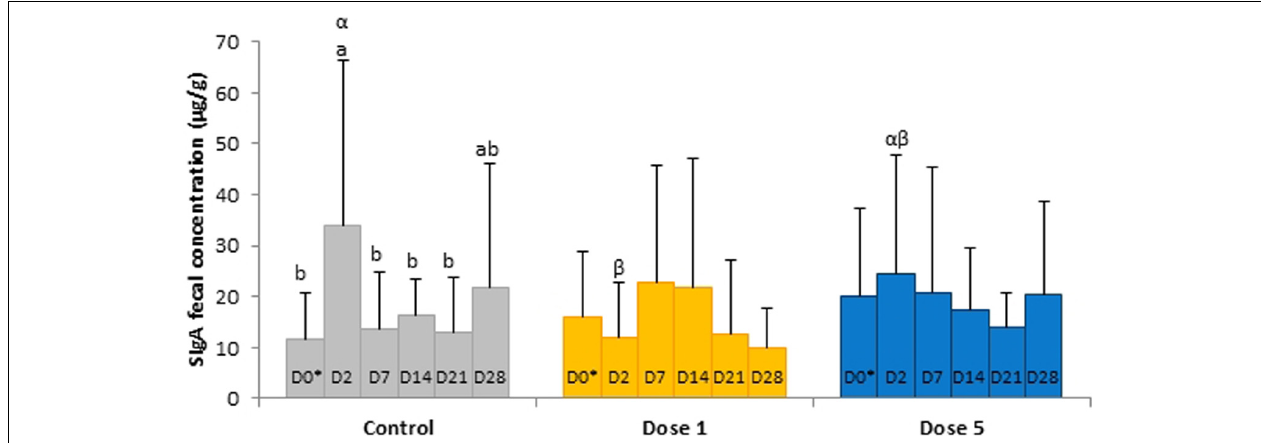
FIGURE 6 | Depiction of significant day × supplementation interactions regarding SIgA concentrations in fecal samples of horses subjected to anoral challenge with TMS from D0 to D4. Different Latin letter superscripts show significant variations between days for each supplementation. Different Greek letter superscripts indicate significant variations between supplementations for each day. ∗ D0: Basal value before the first TMS administration.